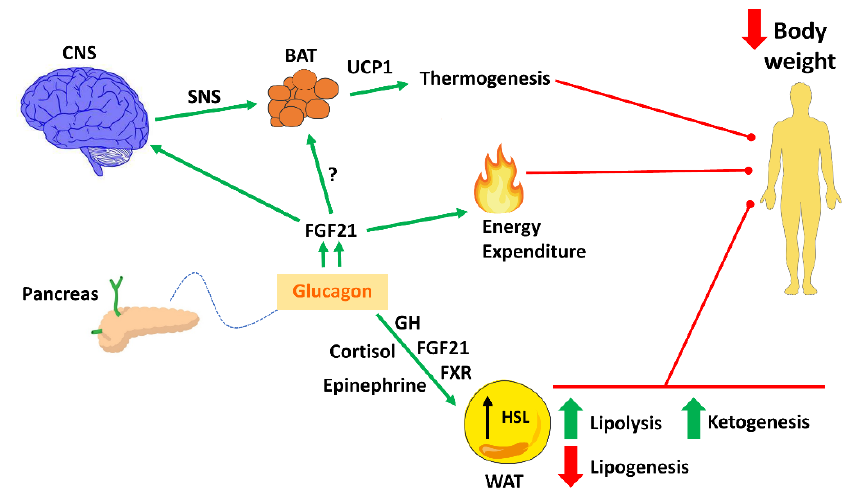
Figure 2. Glucagon on energy balance regulation. Schematic overview of the effects of glucagon on energy balance that finally leads to loss of body weight. Green arrows indicate an increase or improvement, while red arrows indicate a decrease or inhibition. BAT: Brown adipose tissue; CNS: Central nervous system; GH: Growth hormone; HSL: Hormone sensitive lipase; FGF21: Fibroblast growth factor 21; FXR: Farnesoid X receptor; SNS: Sympathetic nervous system; UCP-1: Uncoupling protein 1; WAT: White adipose tissue. Figure made with Servier Medical Art resources.